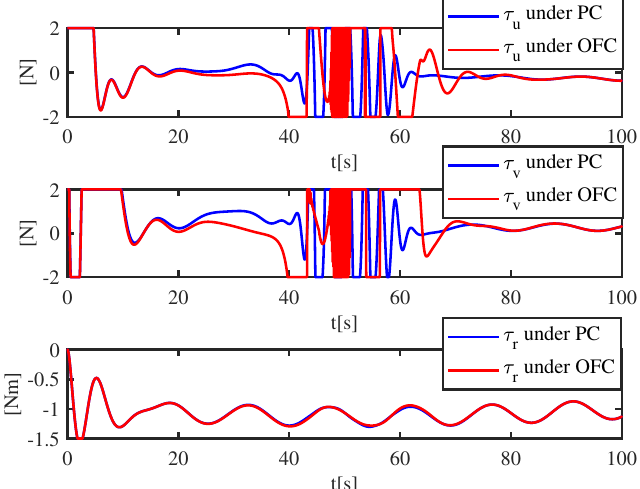
Figure 12. The distances between dynamic positioning vessel and non-cooperative ship under different controllers.